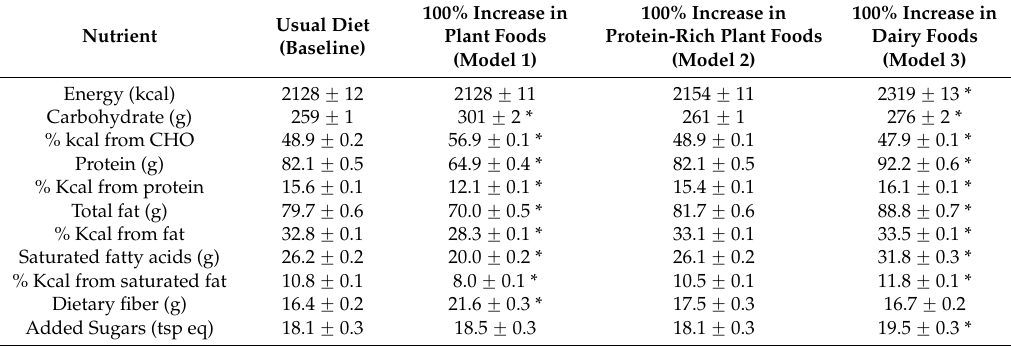
Table 5. Usual macronutrient intake from NHANES 2007–2010 compared to a 100% increase in plant foods, 100% increase in protein-rich plant foods, and 100% increase in dairy foods in adults ě 19 years 1,2